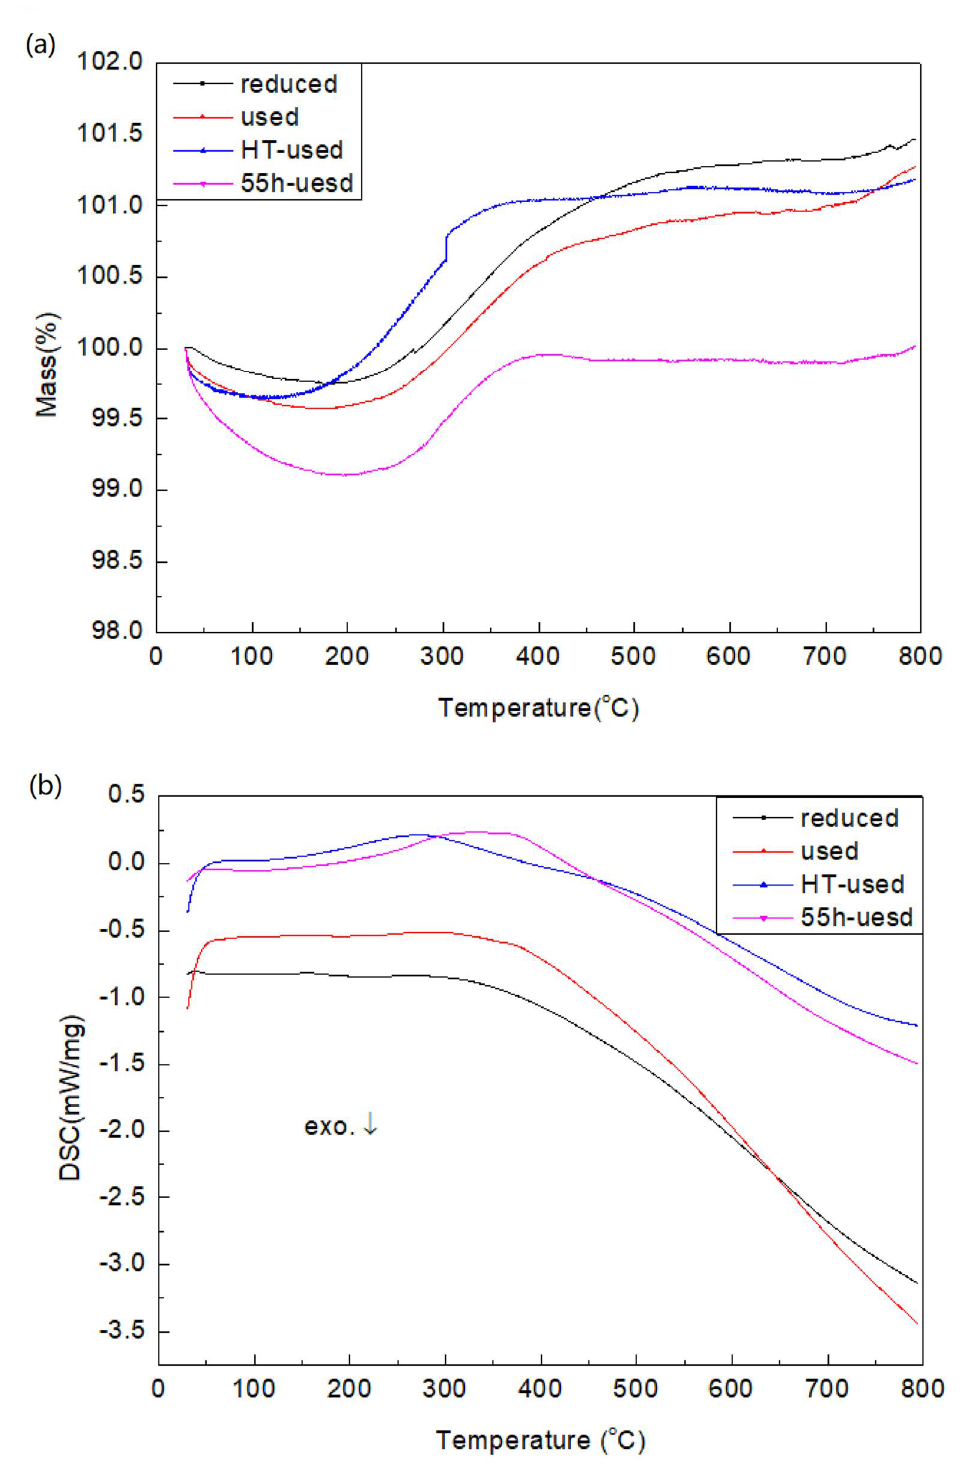
Figure 5. TG-DSC profiles of used sample NCTS(ad): ( a ) Thermogravimetric analysis and ( b ) differential scanning calorimetry analysis.